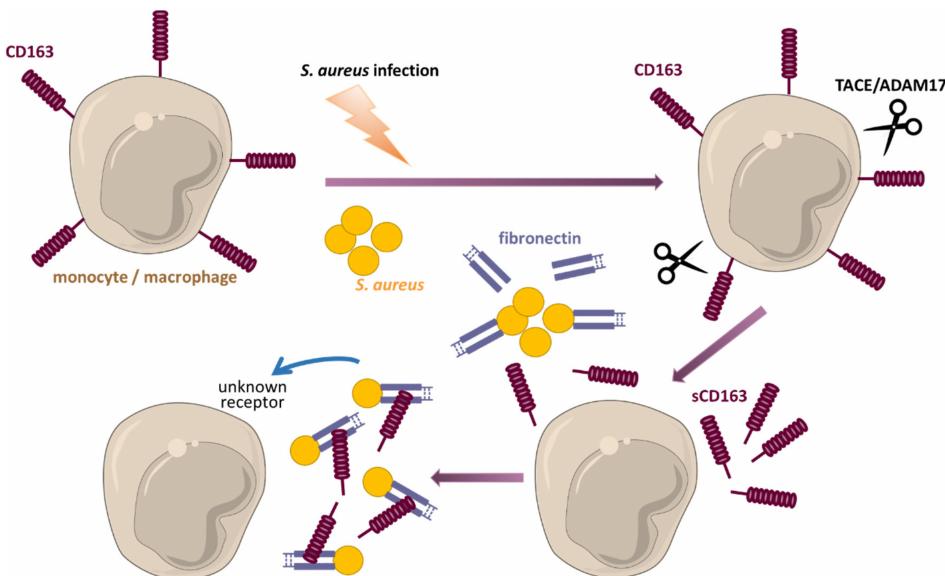
Figure 2. sCD163 modulates the host defense against staphylococcal infections. During sepsis mem- brane bound CD163 undergoes ectodomain shedding that leads to the generation of the soluble form of CD163 (sCD163). This process is mediated via cleavage by metalloproteinase TACE/ADAM17. S. aureus adheres to host tissue by binding of fibronectin. Once released, sCD163 also recognizes and binds to fibronectin, which then acts as a bridge between sCD163 and the staphylococci. This binding promotes the effective clearance (enhanced phagocytosis and killing) of S. aureus by profes- sional phagocytes, while dampening the induction of proinflammatory cytokines and subsequently protecting the host from overwhelming